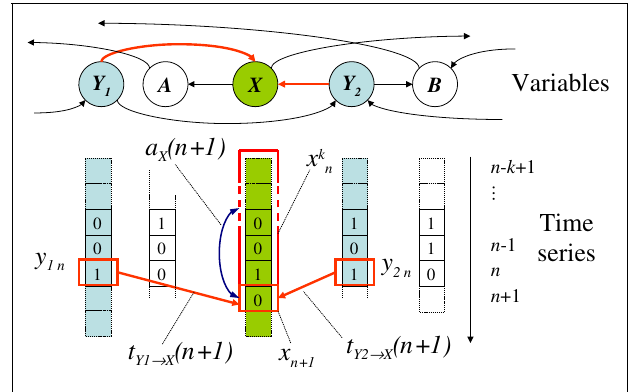
FIGURE 1 | Measures of information dynamics with respect to a destination variable X .We address the information content in a measurement x n + 1 of X at time n + 1 with respect to the active information ( n + 1, k ) and storage a X (n + 1, k ), and local transfer entropies t Y 1 → X ( n + 1, k ) from variables Y t Y 1 and Y 2 2 → X